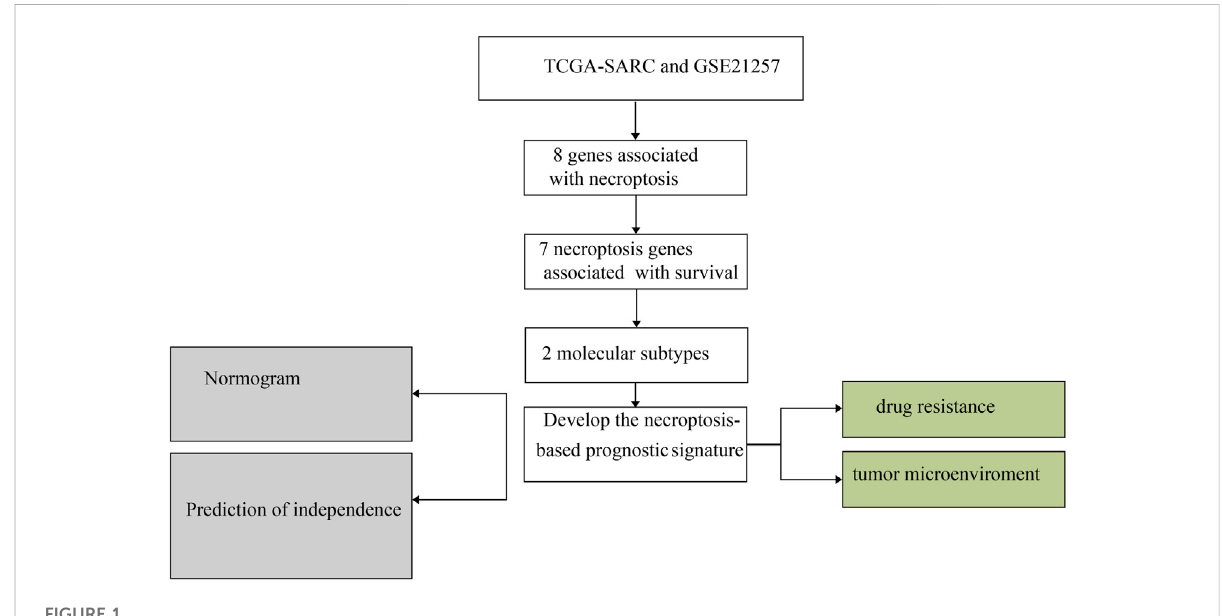
FIGURE 1 The diagrammatic sketch of necroptosis pathway.